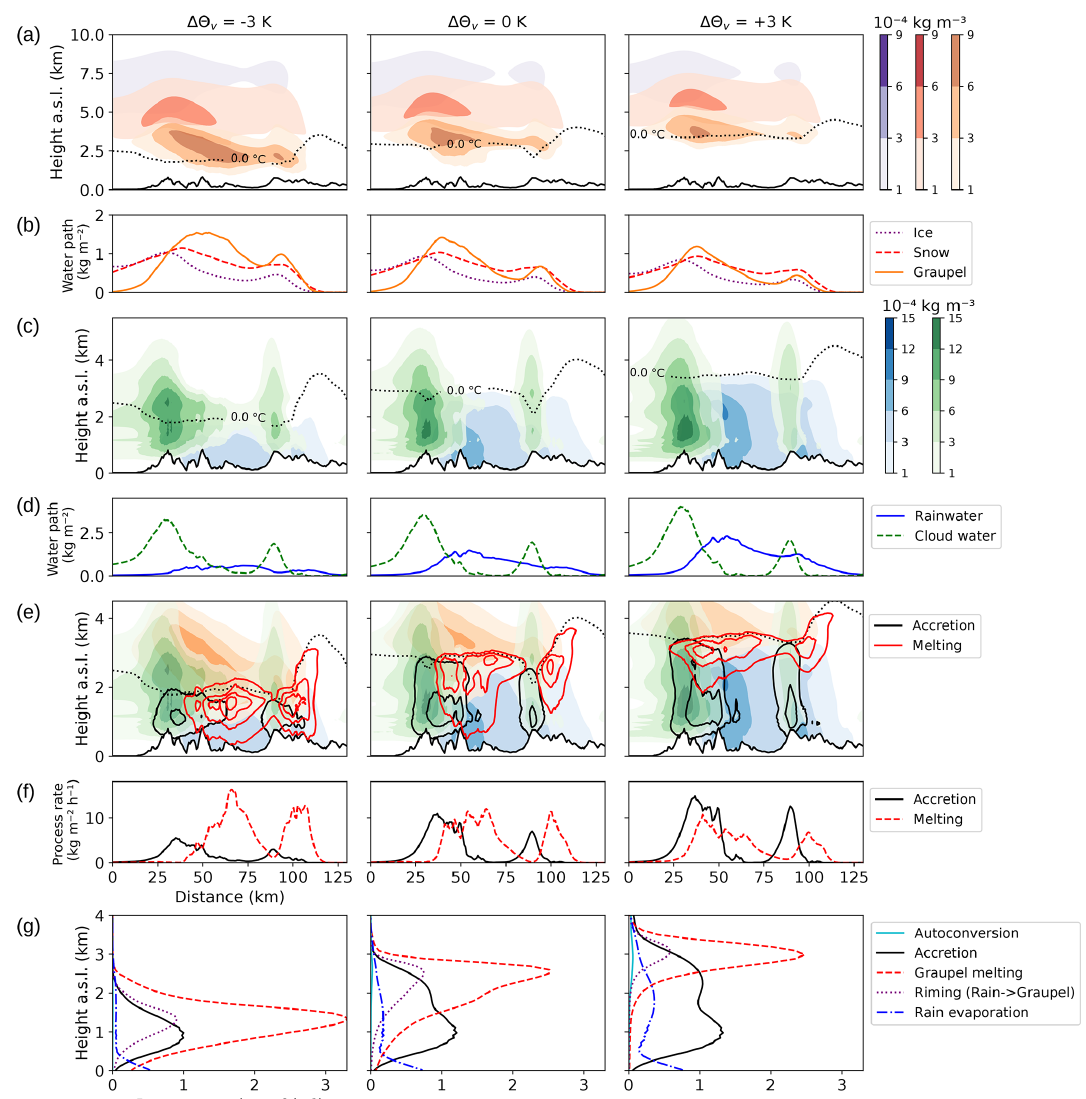
Figure 6. (a) Filled contours of ice (purple), snow (red) and graupel (orange) content along the cross section shown in Fig. 2a. (b) Column- integrated values of the data presented in row (a) . (c) Filled contours of cloud water (green) and rainwater (blue) along the same cross section. (d) Column-integrated values of the data presented in row (c) . (e) Filled contours of graupel (orange), cloud (green) and rainwater (blue) as in rows (a) and (c) together with contours of the melting rate (red lines) and accretion rate (blue lines) at { 1 , 5 , 10 , 15 } gm − 3 h − 1 . (f) Column- integrated values of melting and accretion data presented in row (e) . (g) Vertical profiles of processes contributing to rain generation or rain removal. Values are evaluated inside LAKEDISTR. Columns correspond to the (cid:49)(cid:50) v = − 3K (left), (cid:49)(cid:50) v = 0K (middle) and (cid:49)(cid:50) v = + 3K (right) simulations. All values are 6h averages (from 5 December 2015, 13:00UTC). Orography is outlined at the bottom of row (a) , (c) and (e)